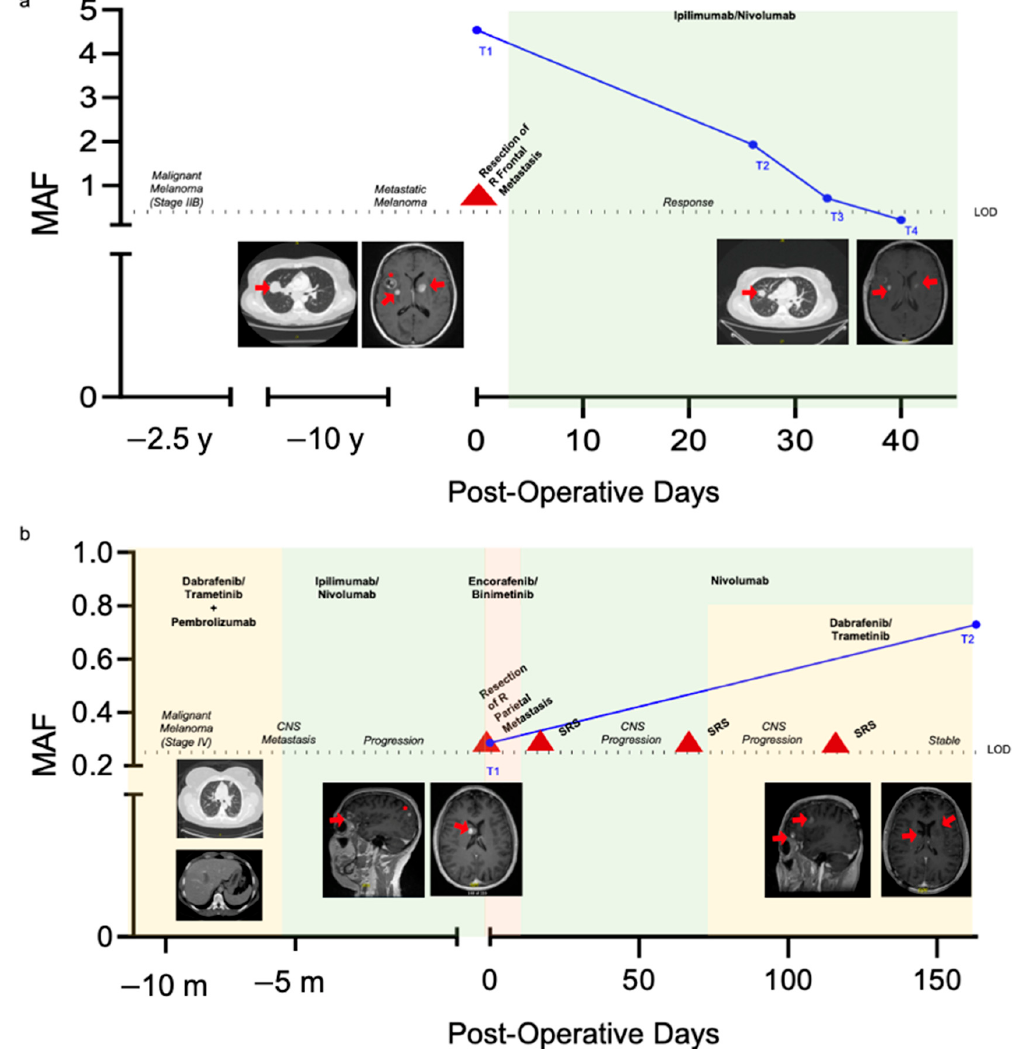
Figure 6. Longitudinal monitoring of BRAF V600E mutant allele frequency in patients with known BRAF V600E mutant metastatic melanoma. MAF (blue, %) as determined by the ddPCR Plasma Assay is plotted relative to post-operative days. Timepoints for the plasma assay are shown. The threshold for assay positivity, the LOD, is denoted by the dotted line. Chemotherapy regimens are signified by colored background shading and surgical and stereotactic radiosurgery (SRS) interventions are denoted by a red triangle. Intra- and extracranial metastatic foci that can be appreciated in either axial or sagittal T1 post-contrast images are highlighted with a red arrow. Longitudinal imaging of select metastasis with significant change are also shown. The CNS metastasis that was biopsied/resected is highlighted with a red star. Data for P1 is shown in ( a ) and P3 in ( b